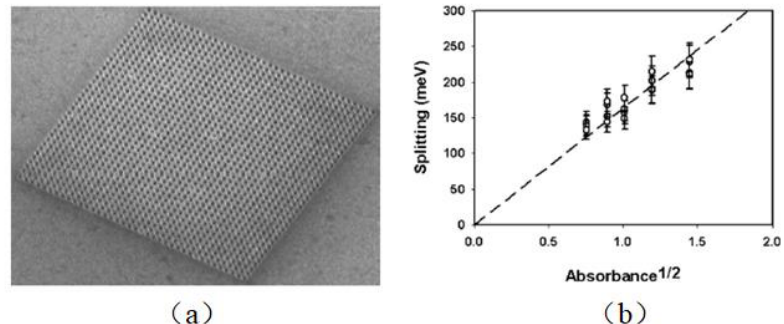
Figure 4. (a) Scanning electron image of typical hole array milled into a silver film. ( b ) Variation of Rabi splitting as a function of the square root of the absorbance of the J-aggregate/polyvinyl alcohol (PVA) film [57].